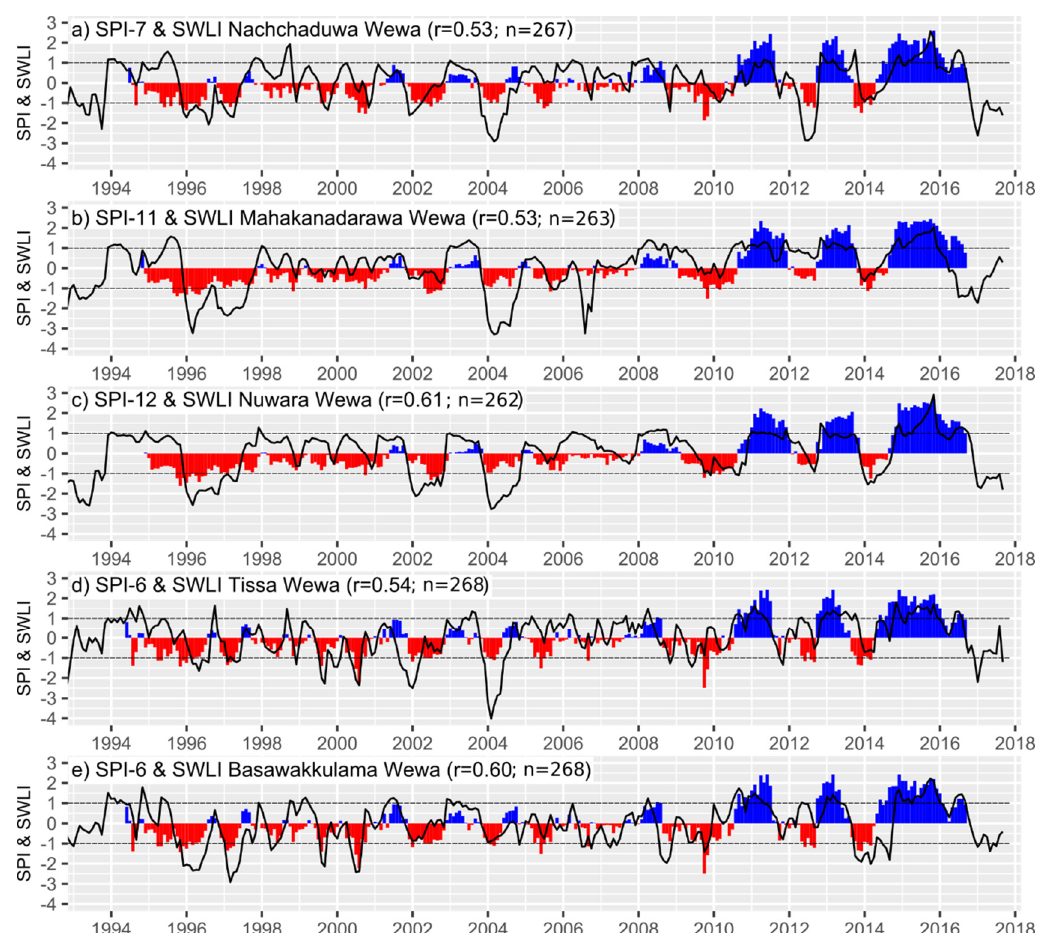
Figure 7. SPI (blue and red bars) and SWLI (black line). The SPI time scale displayed shows the best correlation expressed by the correlation coefficient (r) between SPI time scales and SWLI for each tank: ( a ) Nachchaduwa Wewa, ( b ) Mahakanadarawa Wewa, ( c ) Nuwara Wewa, ( d ) Tissa Wewa, ( e ) Basawakkulama Wewa (n = sample size). Dashed lines mark the classification ‘near normal’ for both indices [24].